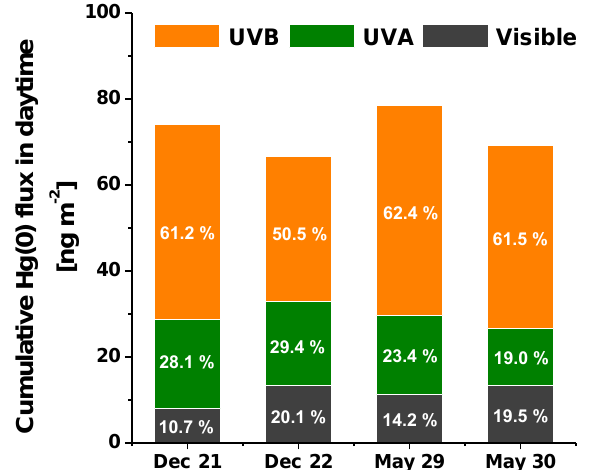
Figure 8. Cumulative Hg(0) emission flux in the daytime triggered by UVB, UVA and visible light in four study days during the De- cember 2014 campaign and May–June 2015 campaign.